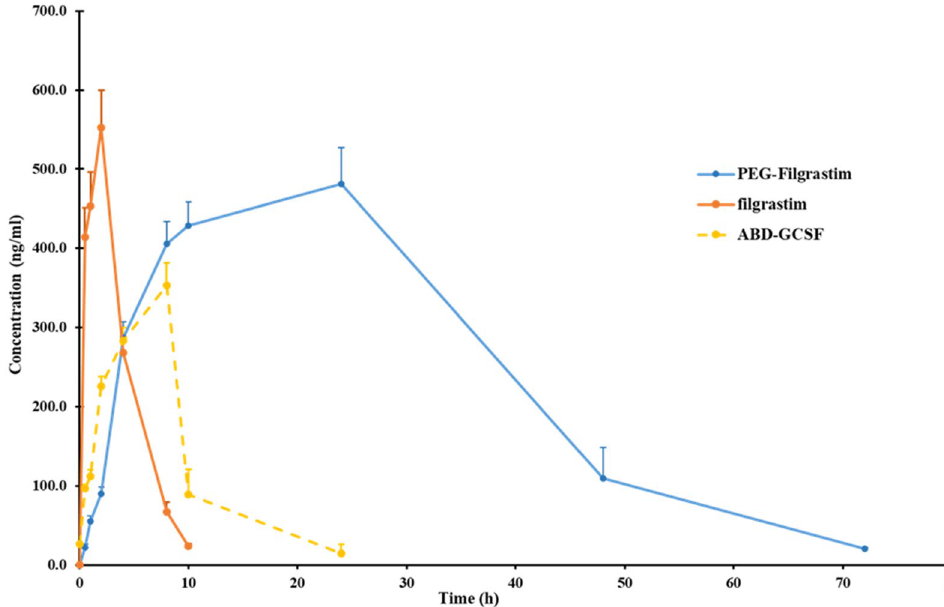
Figure 10. Plasma concentration–time profile of Filgrastim, PEG-Filgrastim and ABD-GCSF in rats. 5 rats/ group subcutaneously received GCSF derivatives. All points report the mean ± SD of